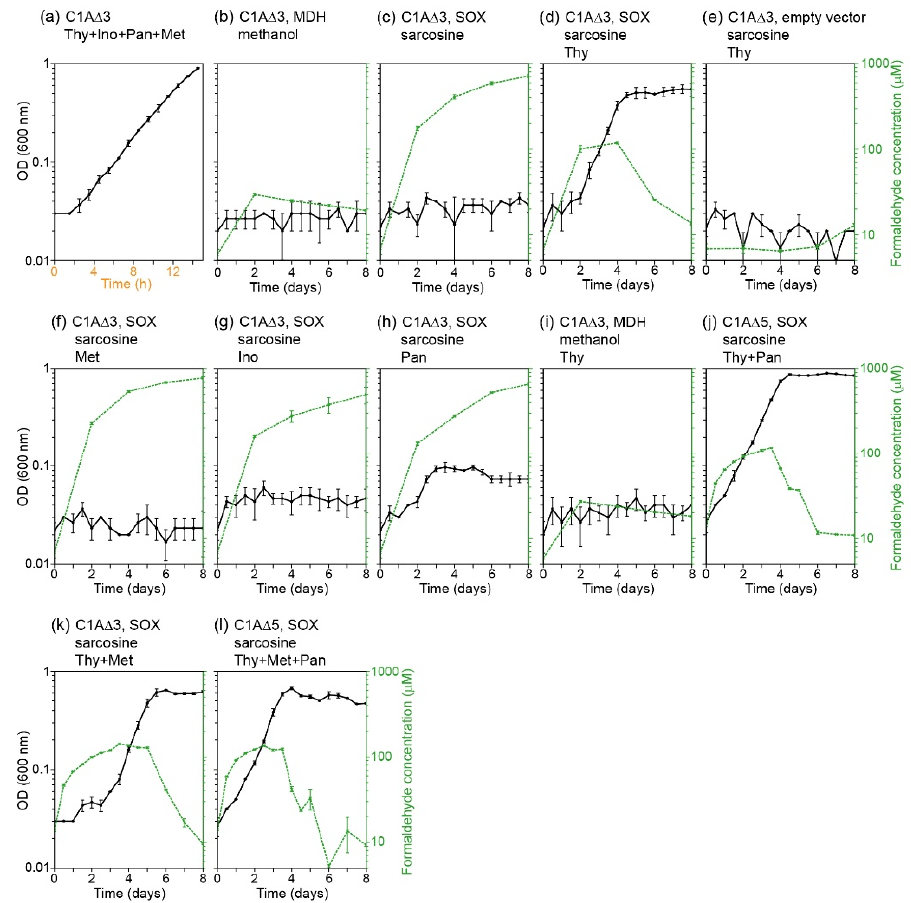
Figure 2. Growth of the C1A ∆ 3 and C1A ∆ 5 strains with formaldehyde as source of 5,10-methylene-THF. The strain and carbon sources used in each experiment are shown above each box. Note that the scale of x-axis in panel (a) is di ff erent from the others. C1A ∆ 3 corresponds to ∆ glyA ∆ gcvTHP ∆ frmRAB , C1A ∆ 5 corresponds to ∆ glyA ∆ gcvTHP ∆ frmRAB ∆ panB ∆ ltaE , MDH to methanol dehydrogenase, and SOX to sarcosine oxidase (Table 1). Strains were cultivated on a minimal medium with 10 mM glucose, supplemented either with 1 mM sarcosine or with 700 mM methanol + 1 mM glycine, and further supplemented (as indicated in the title) with 0.3 mM thymidine (Thy), 0.3 mM methionine (Met), 0.3 mM inosine (Ino), or 6 µ M pantothenate (Pan). Solid black lines correspond to OD 600 , while dashed green lines indicate formaldehyde concentrations. Error bars represent standard deviations with n =